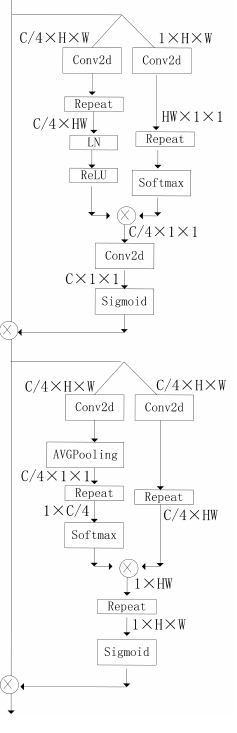
Figure 6. Polarized self-attention